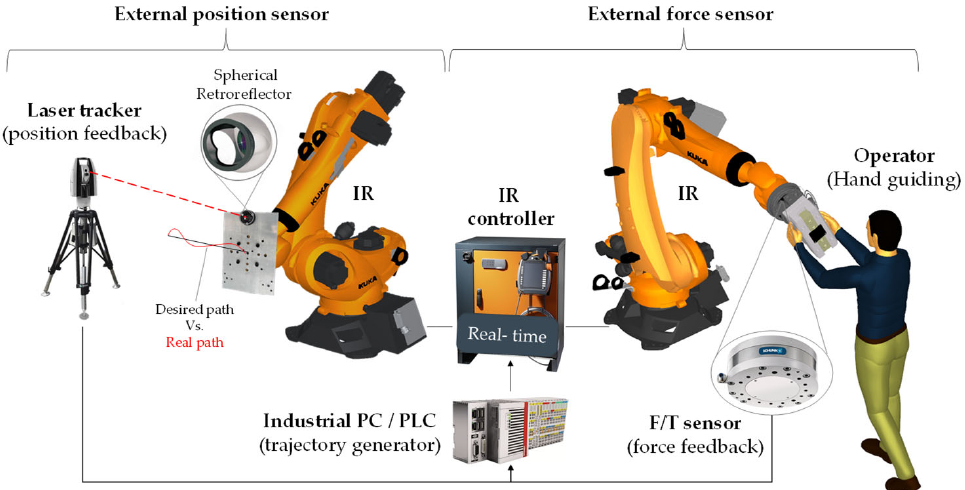
Figure 4. Closed-loop real-time position- and force-based guided motions. On the left, an example of precise robot positioning with laser tracker feedback; on the right, an application of hand-guiding on a high payload IR. Table 3. Examples of external trajectory generators from literature.